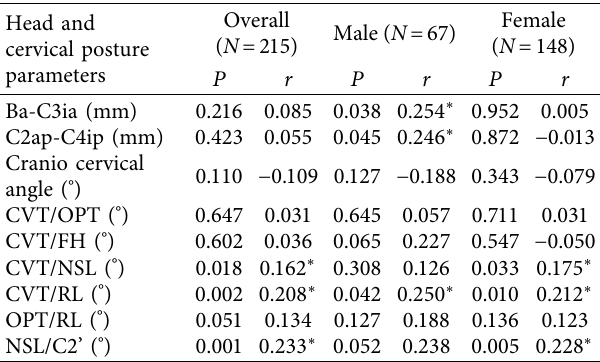
Table 6: Correlation between the FAI score and head and cervical posture parameters in TMD